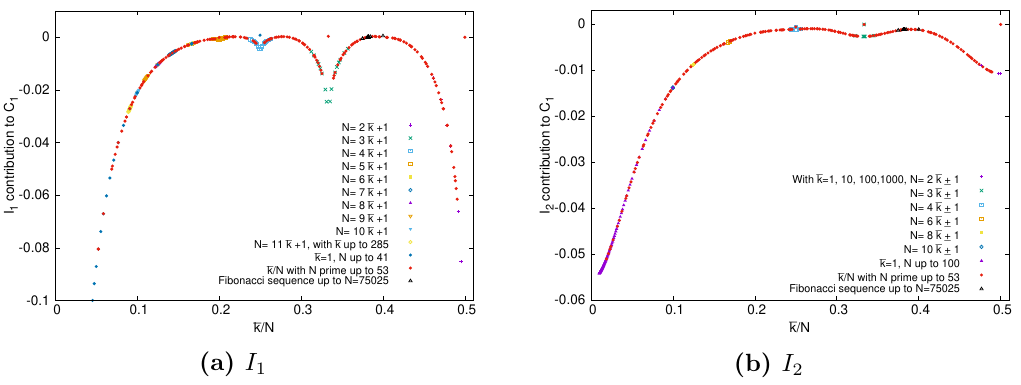
Figure 4. Dependence on ^ (cid:18) of the I 1 and I 2 contributions to C 1 at c = 0 :